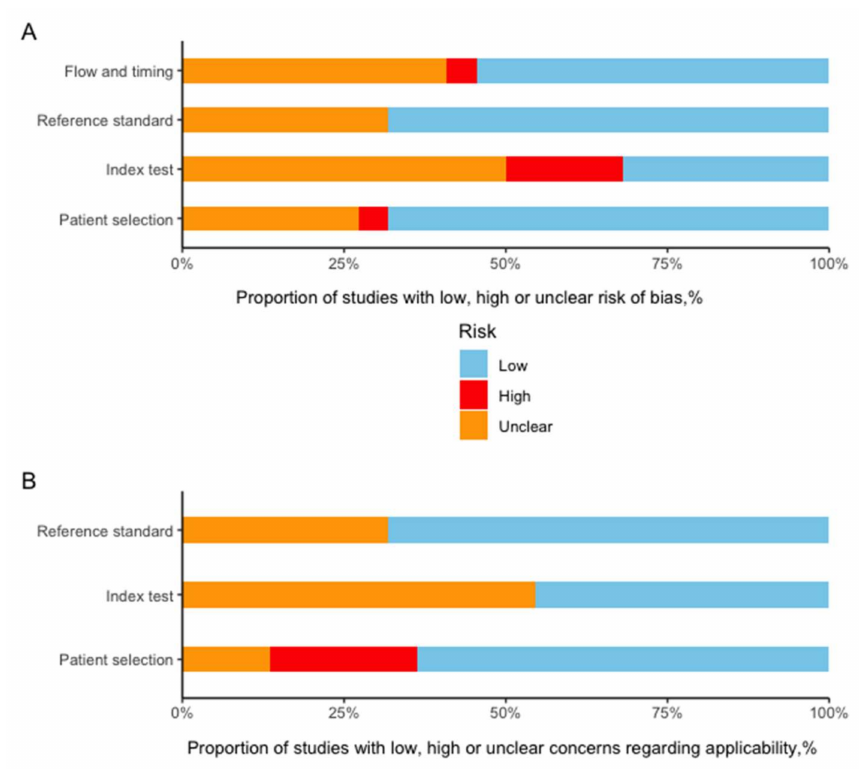
Figure 4. Grouped bar charts of the risk of bias ( A ) and applicability concerns ( B ) of the included studies assessed by using a revised tool for the Quality Assessment of Diagnostic Accuracy Studies